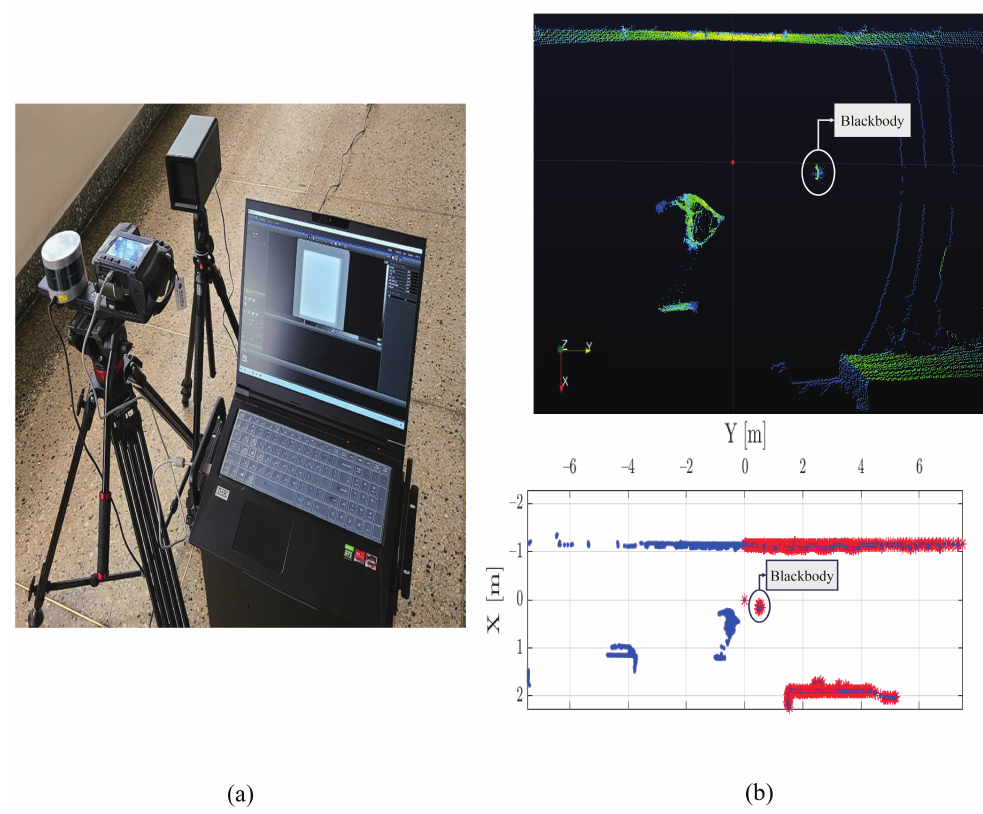
Figure 13. Experiment environment: ( a ) Picture ( b ) LiDAR map.